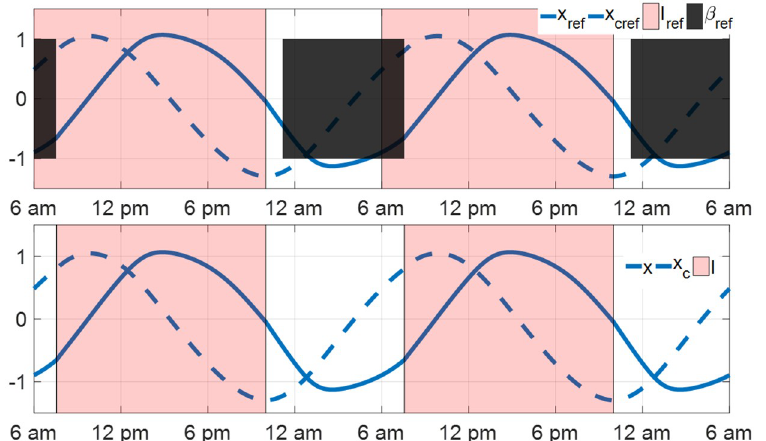
Fig 7. The periodic circadian state of the JFK model with (upper) and without (lower) Process S and sleep-wake cycle. The red region in the upper panel shows the reference daily light is present between 6 am and 10 pm, the black region in the upper panel indicates the reference sleep period is from about 11:10 pm to 7:30 am. The red region in the lower panel shows the actual daily light that the reference subject receives is from 7:30 am to 10